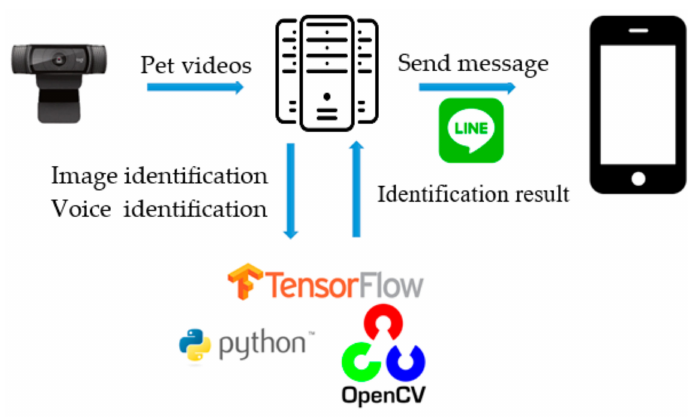
Figure 5. System